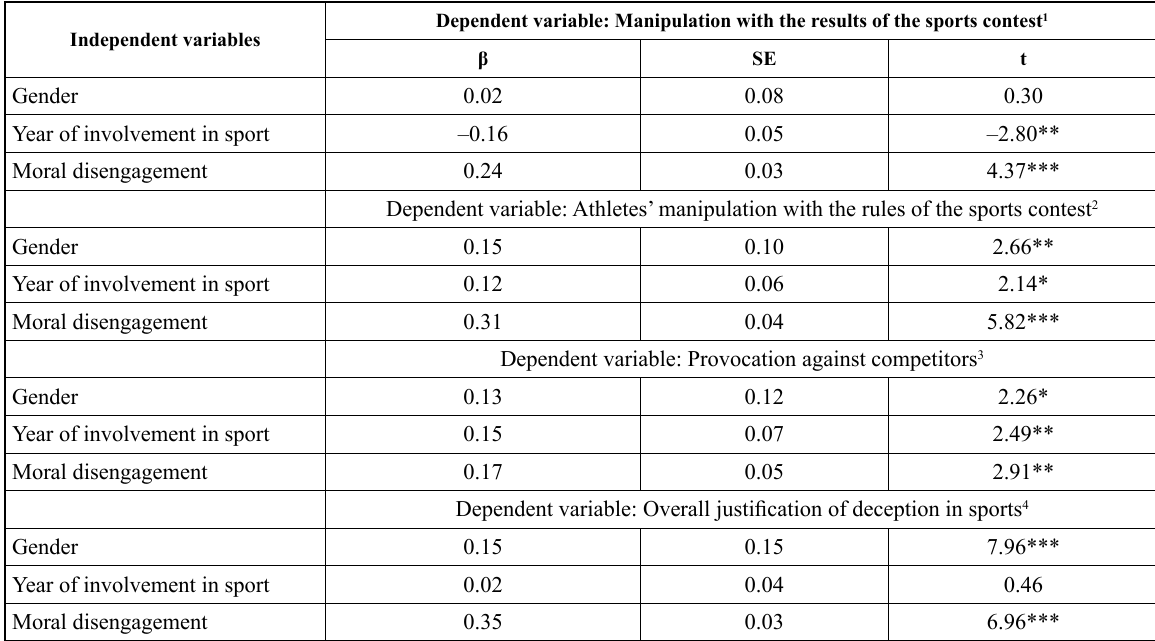
Table 3. Regression analyses predicting justification of cheating in sport (n = 338) Dependent variable: Manipulation with the results of the sports contest Independent variables